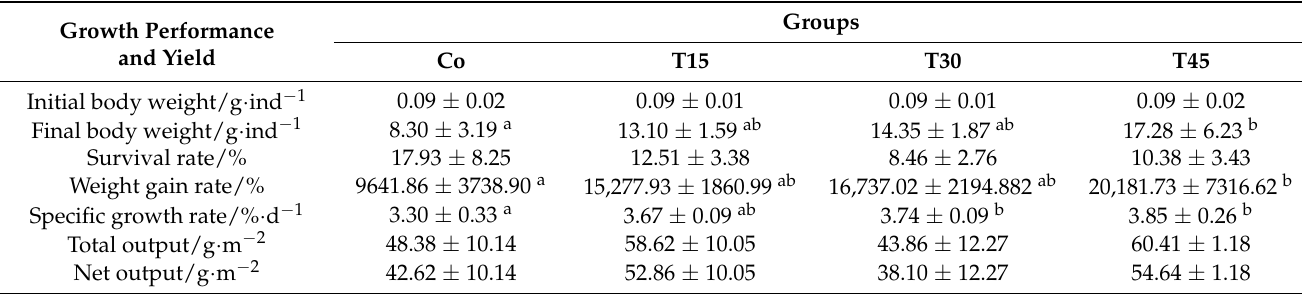
Table 2. Effects of different dietary protein content levels on the growth performance and yield ( n = 3; x ± SD) of juvenile Chinese mitten